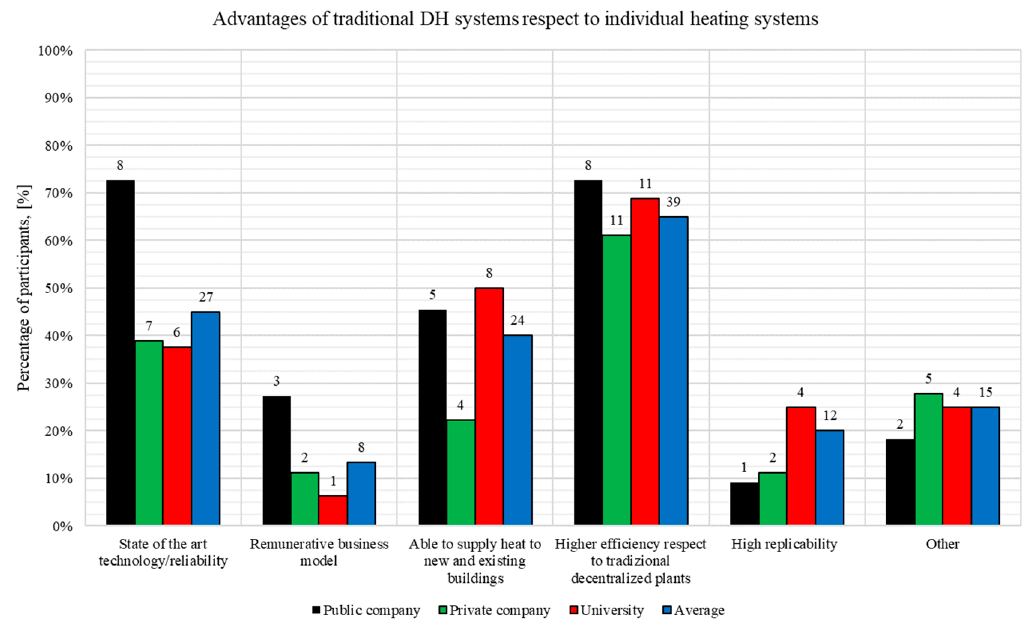
Figure 14. Advantages of traditional DH systems with respect to individual heating systems as a function of the organization type.